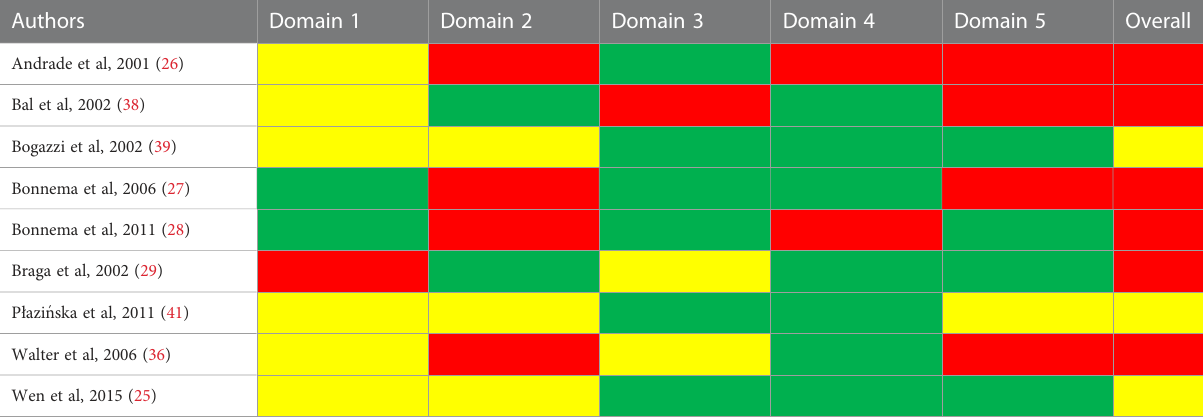
TABLE 4 Cochrane risk-of-bias tool for randomized trials (RoB 2).